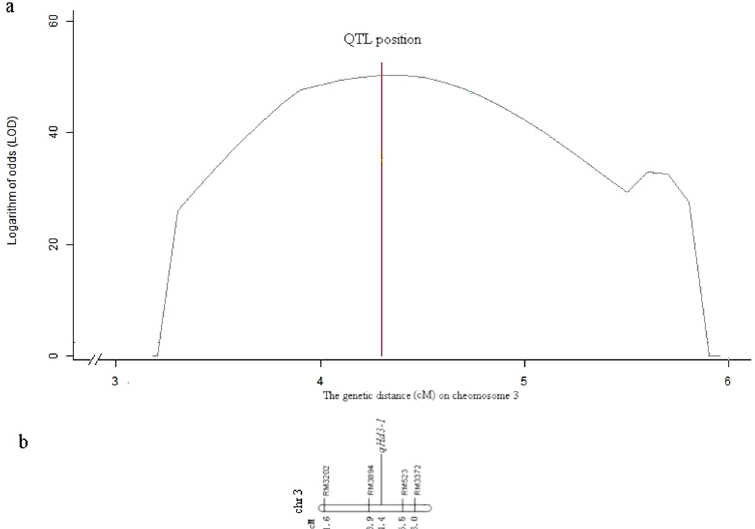
Figure 2. Fine position of QTL qHd3-1 on chromosome 3 mapped by the software of QTL.gCIMapping. ( a ) Genetic distance–LOD curve. ( b ) Fine position of QTL qHd3-1 on chromosome 3. Markers and QTL appeared above the chromosome, and their corresponding positions were ranged below the chromosome.